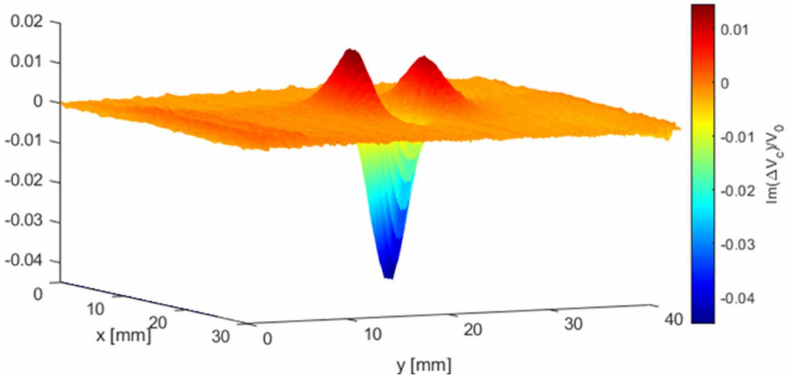
Figure 8. The 3-D imaging of the imaginary part of the normalised voltage change (due to the crack) using the T-R sensor (tilt angle ϕ = 0 degree) for the inspection of a surface notch with a depth of 1.6